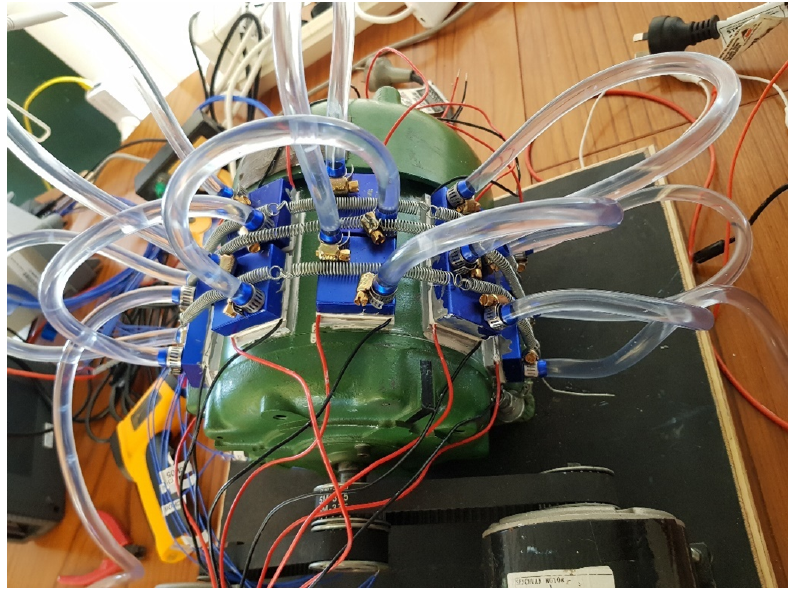
Figure 14. The setup of the heating of the test motor with the TECs and water cooled heat